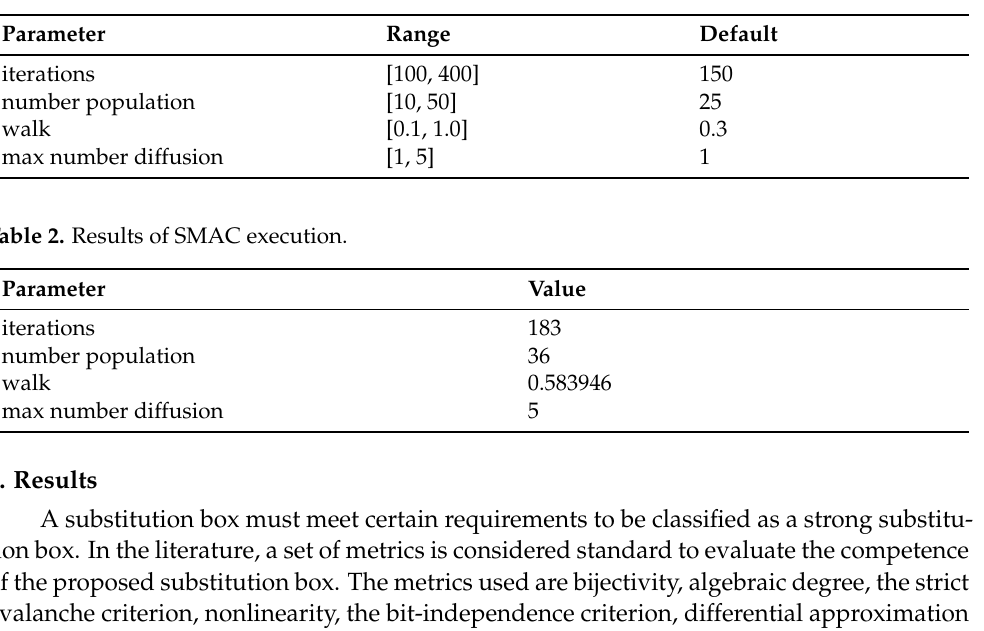
Table 1. Scenario delivered to SMAC for execution.